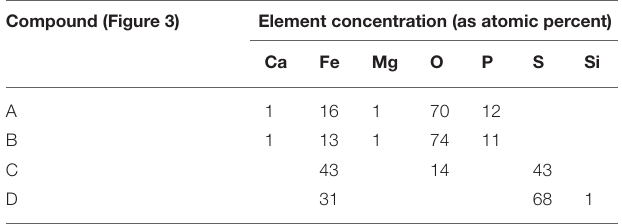
TABLE 3 | Elemental analysis of the iron precipitates observed in the Figure